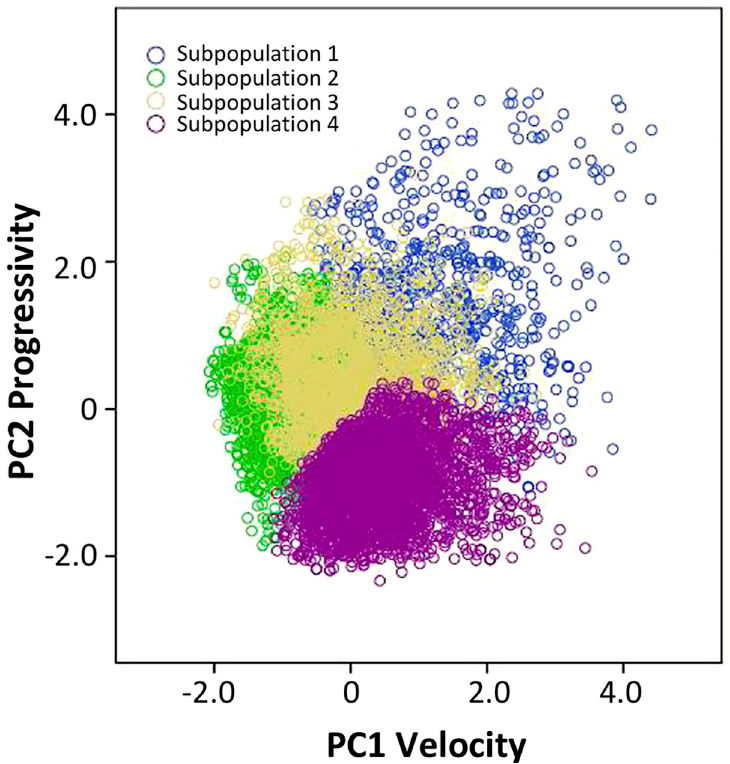
Fig 2. Distribution of sperm subpopulations of American crocodile ( Crocodylus acutus ) according to their principal components values.